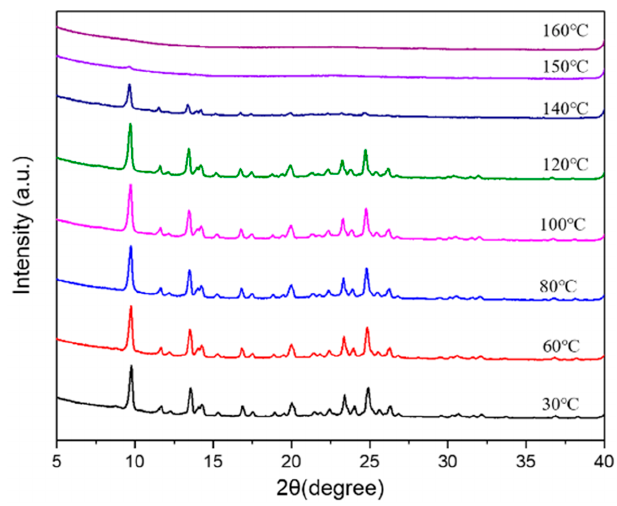
Figure 11. In situ variable temperature XRD patterns of BUCT-3.